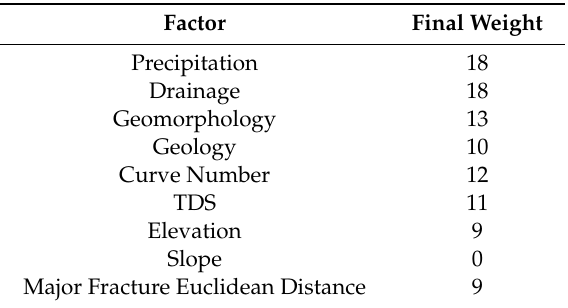
Table 6. Revised parameters weighting of the thematic